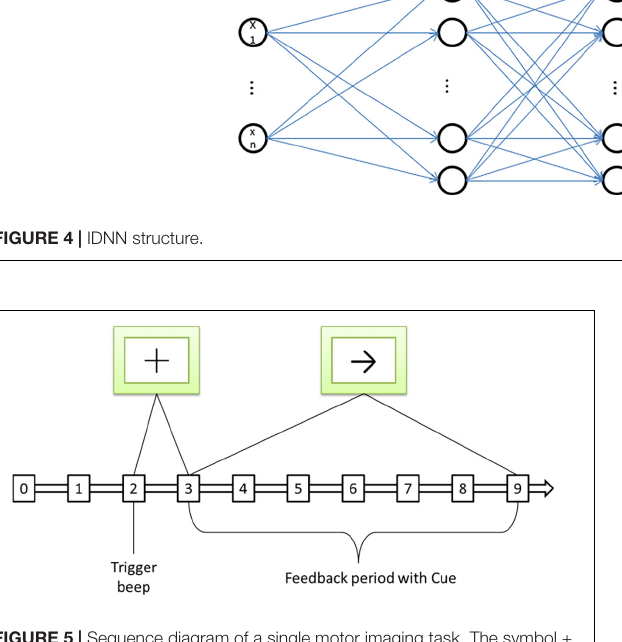
FIGURE 5 | Sequence diagram of a single motor imaging task. The symbol + represents the start signal, and the symbol → represents the directional signal.